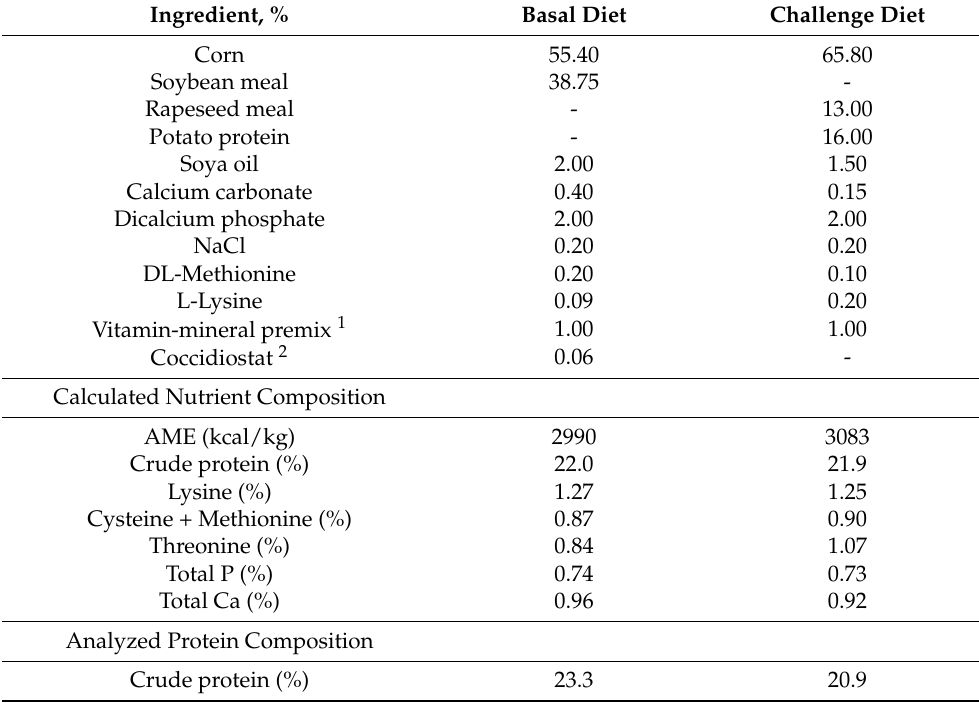
Table 1. Ingredient composition and nutritional specifications of experimental diets (Trial